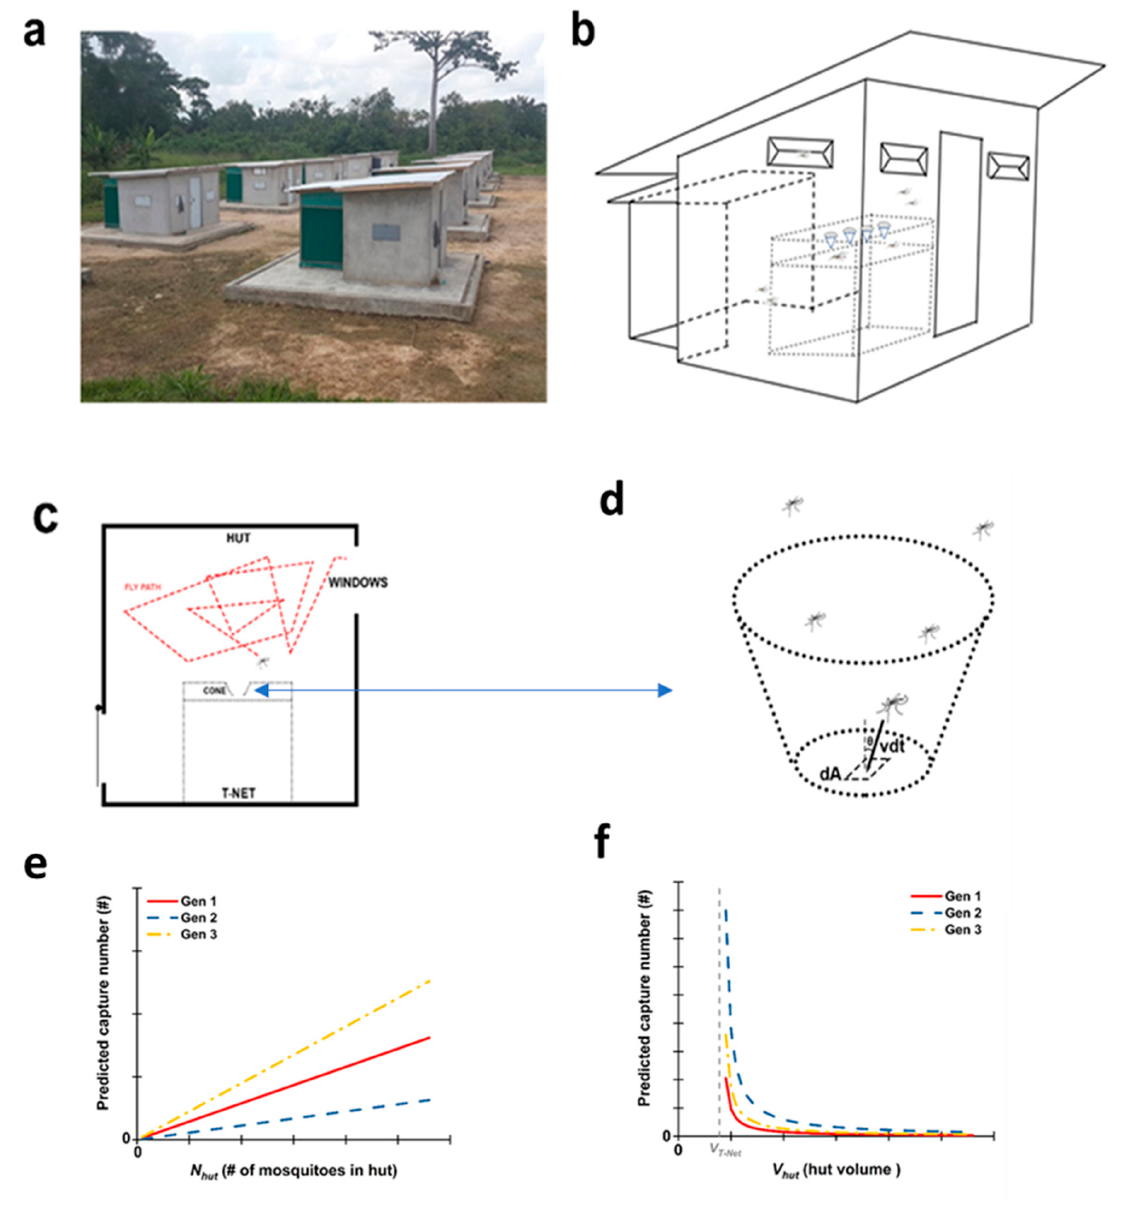
Figure 1. Principle and model of the T-Net. ( a ) Picture of experimental huts in the region of Tiassale in Cote d’Ivoire (Africa), where the field trials were conducted; ( b ) schematic of the hut and the T-Net deployed in the hut; ( c ) schematic of the mosquito flight track in the hut; ( d ) unit area on the bottom of the T-Net cone that captures the mosquito; ( e ) predicted capture number for Gen1, Gen2, and Gen3 T-Nets (see Figure 2a–c, respectively) with an uncertain number of mosquitoes flying into the hut; and ( f ) the predicted capture number for Gen1, Gen2, and Gen3 T-Nets when hut volume increases and the number of mosquitoes flying into the hut is constant.